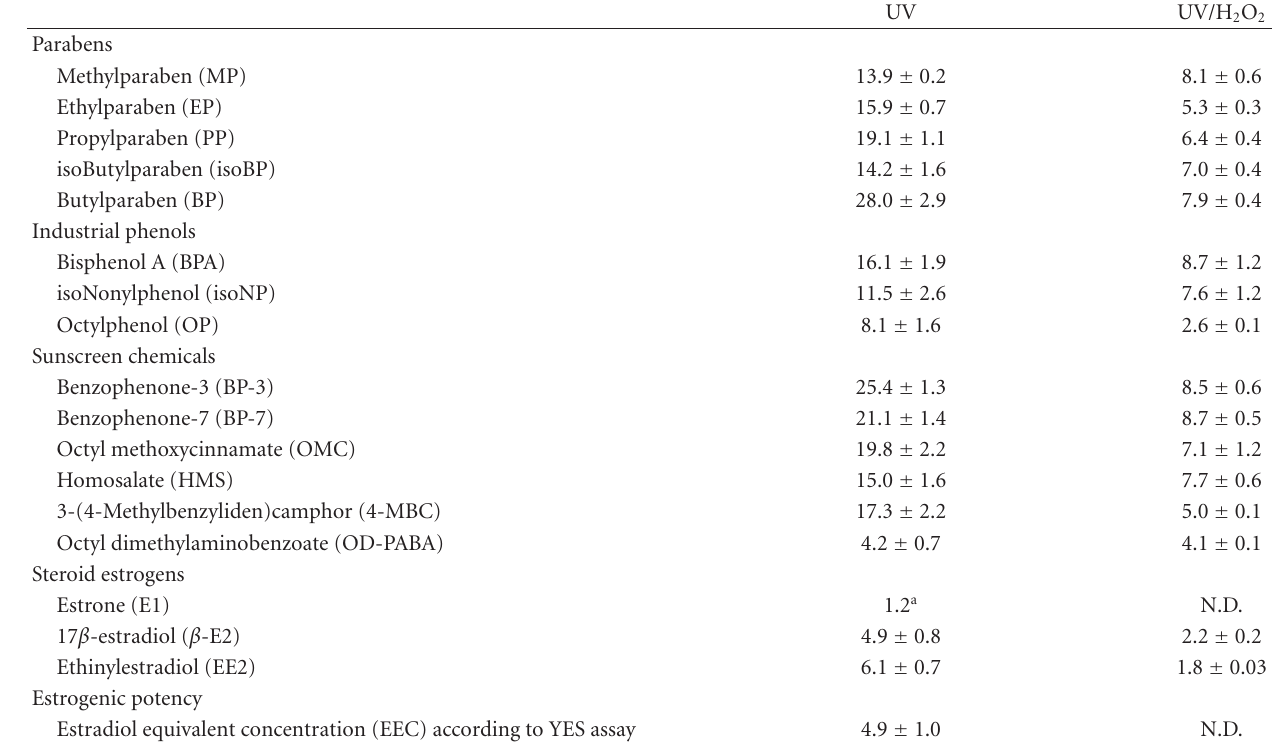
Table 1: The electrical energy per order, EEO, (kWh/m 3 ) for UV and UV/H 2 O 2 treatments of the investigated compounds in treated wastewater from Usserød WWTP. 95% confidence intervals are